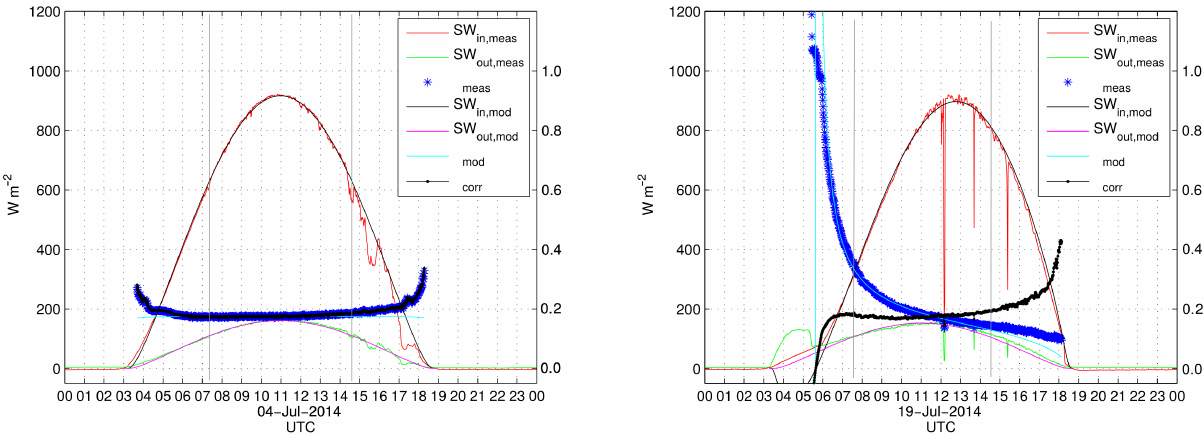
Figure 2. Measured, modelled and corrected SW in , SW out and α with a horizontally levelled (left) and an intentionally inclined pyranometer (right) at WHW for 2 days in July 2014.